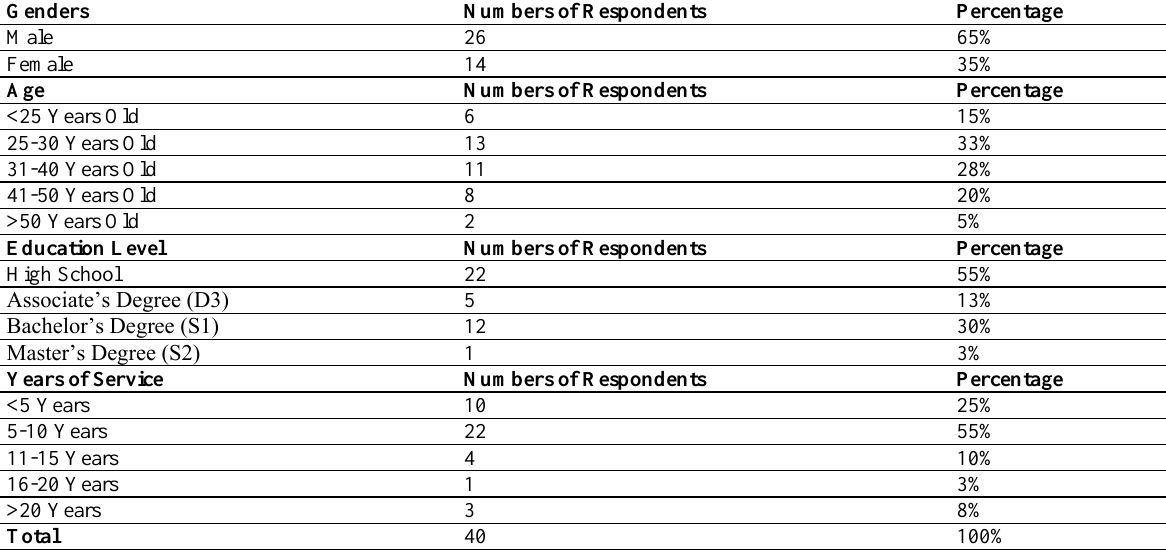
Table 1: Respondent’s